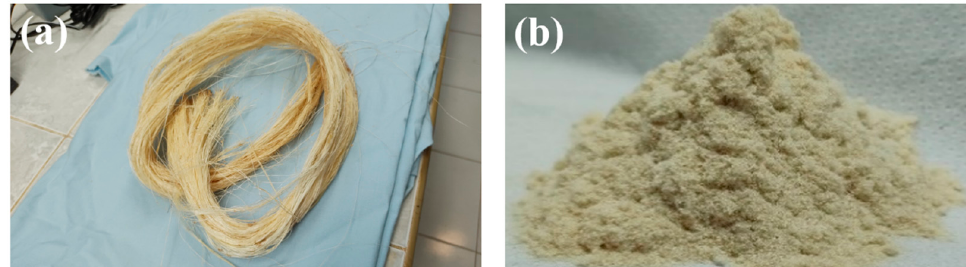
Figure 1. ( a ) henequen fibers; ( b ) henequen fiber